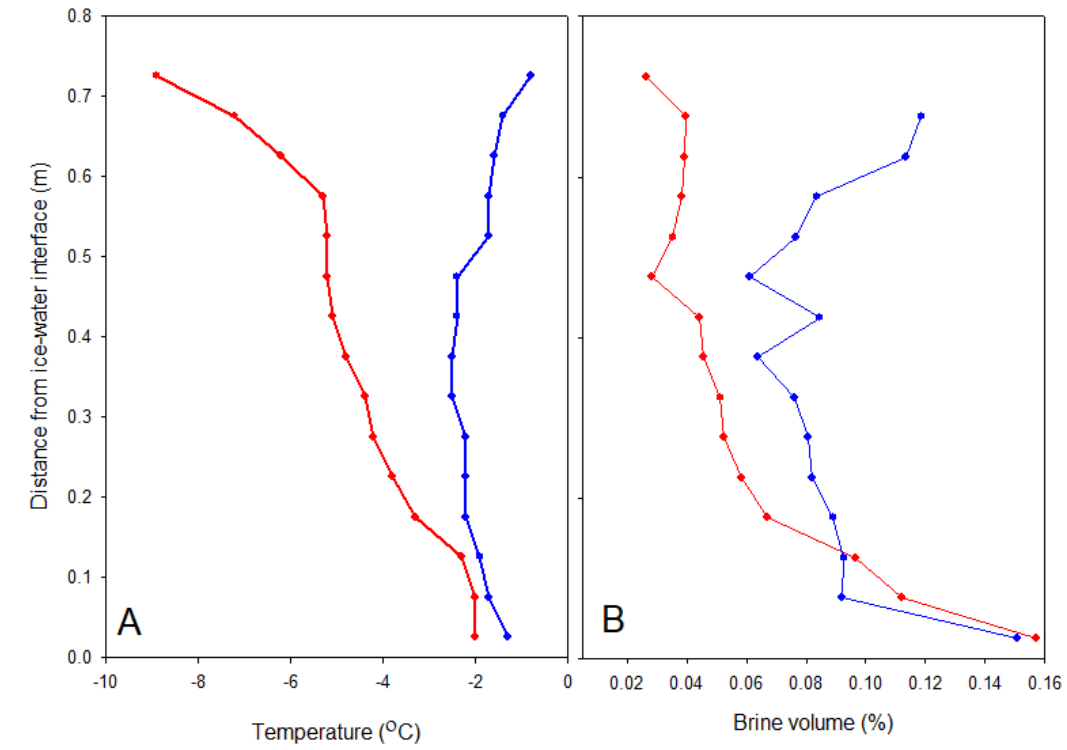
Figure 4. Ice temperature ( A ) and brine volume ( B ) profiles during the cold (pre-snowmelt, Day 73, red line) and warm (post-snowmelt, Day 77, blue line) phases of the experiment. Values are means at each depth from two cores. Table 1. Mean ± SD ( n = 3) for Chl a , DOC (dissolved organic carbon), Φ PSII_max , α , rETR max , and E k for the lower 30 mm of the ice before (Days 71 and 73) and after (Days 77 and 79) snowmelt on the fjord. F values from repeated-measures ANOVA shown with significant tests identified as p < 0.05 *, p < 0.01 **. Different letter superscripts within rows identify means that differ significantly where ANOVA is significant. Chl a and DOC were sampled on all four occasions; photobiology (Phyto-PAM) was not performed on Day 71 (n.d. = not determined). Degrees of freedom are 3, 9 for Chl a and DOC, and 2, 6 for